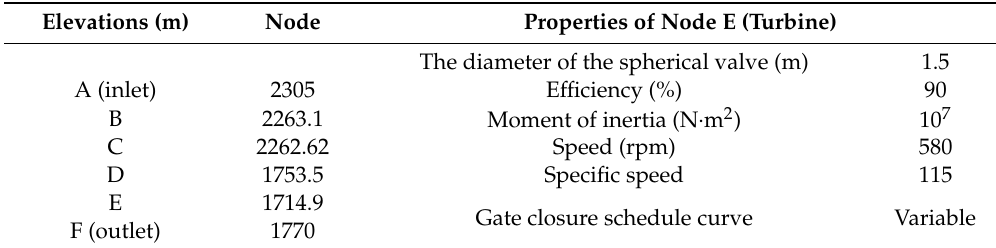
Table 3. Node elevations and properties of node E (turbine).